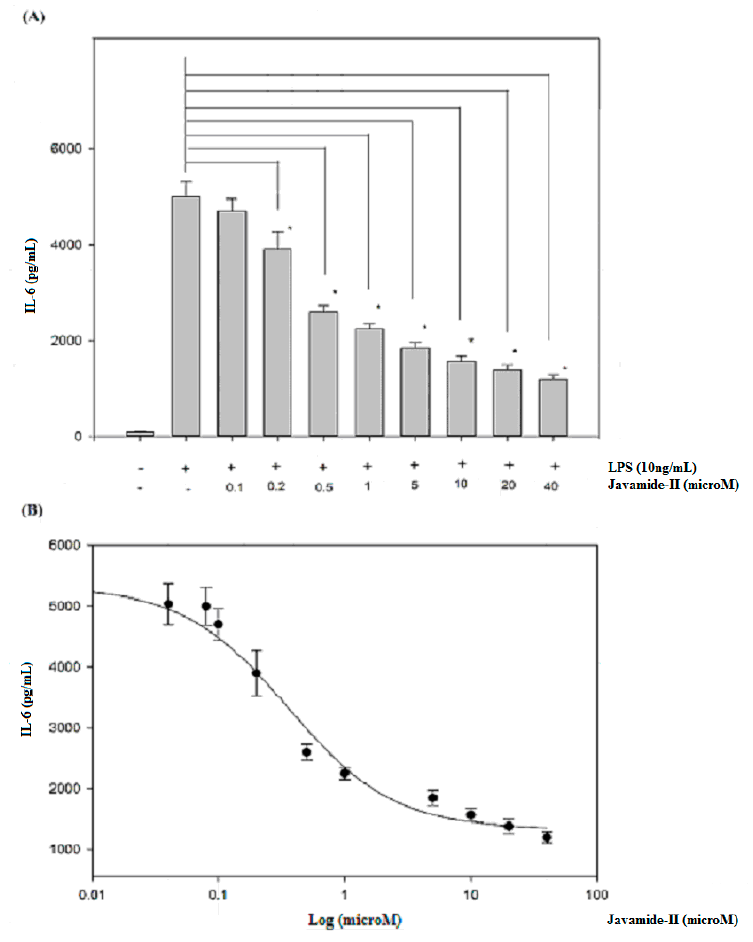
Figure 1. The effect of javamide-II on the expression of IL-6. ( A ) IL-6 production was determined at the concentrations of javamide-II (0, 0.1, 0.2, 0.5, 1, 5, 10, 20 and 40 µM) in LPS-treated PMA-differentiated THP-1 cells. The P value was calculated using one-way ANOVA with the Holm–Sidak method, and the asterisks (*) denote significant differences ( P < 0.02) compared to the LPS control. ( B ) IC 50 curve. Data points are shown as the means ± SD ( n = 7).